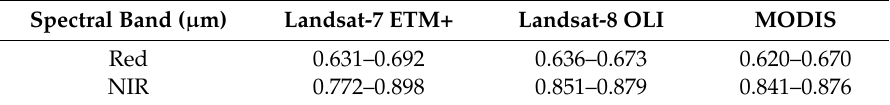
Table 1. Comparison between Landsat 7 ETM+, Landsat 8 OLI, MODIS NIR, and Red spectral